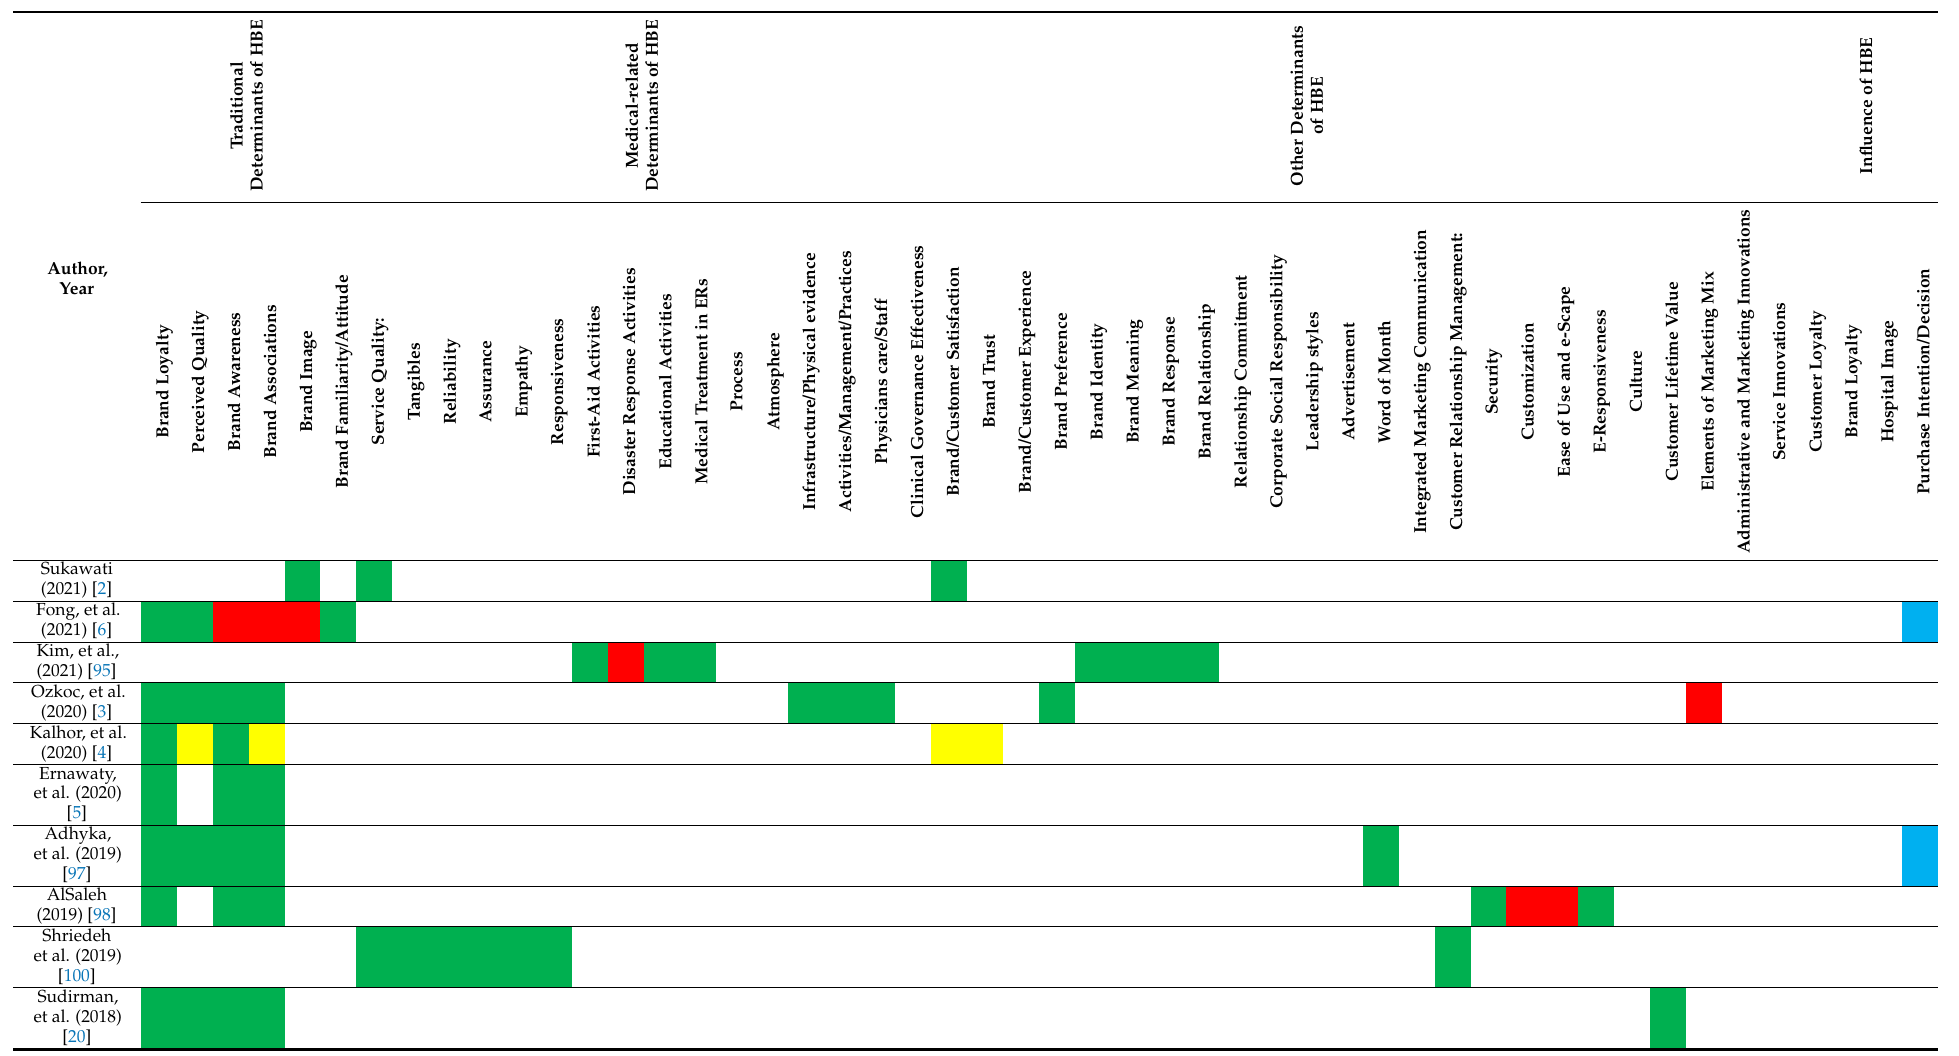
Table 3. Map of all HBE